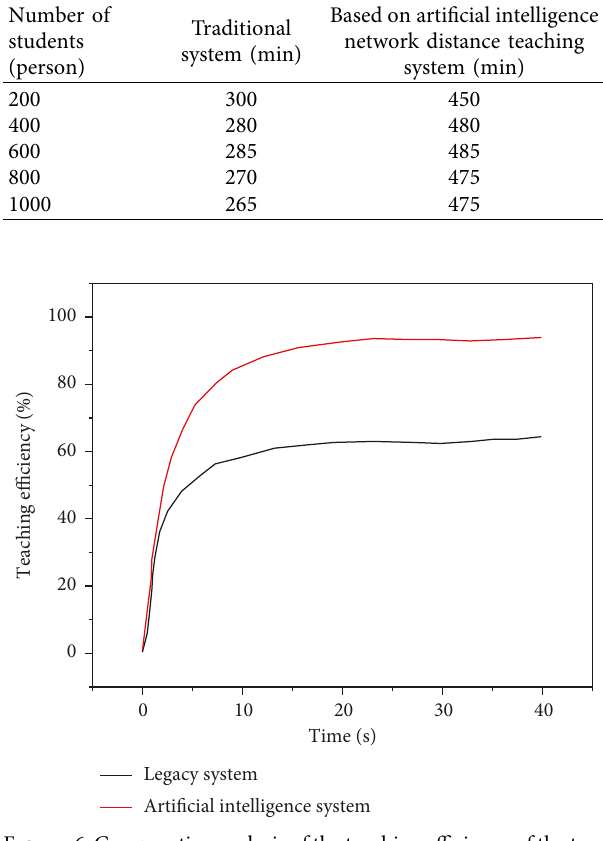
Figure 6: Comparative analysis of the teaching efficiency of the two systems.